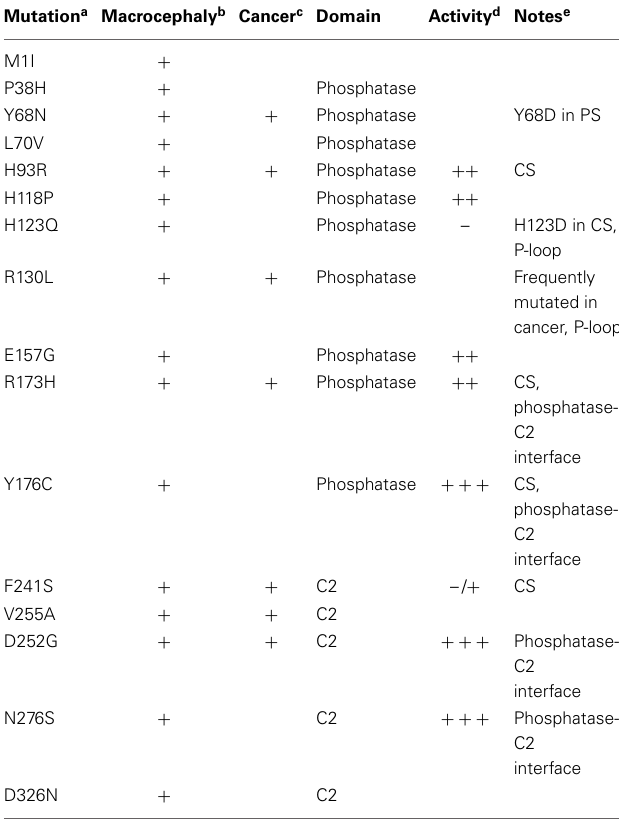
Table 1 | ASD-associated missense